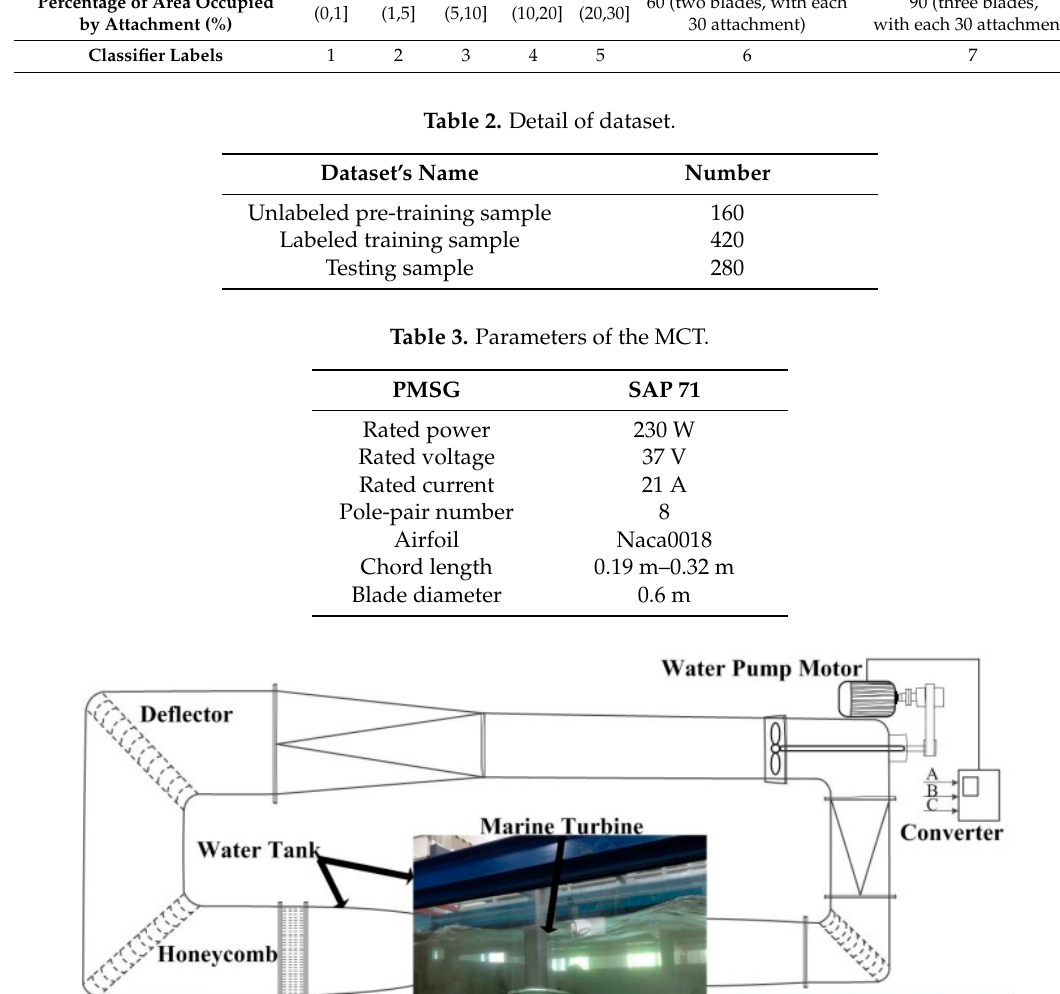
Figure 6. Single blade with different degrees attachment.